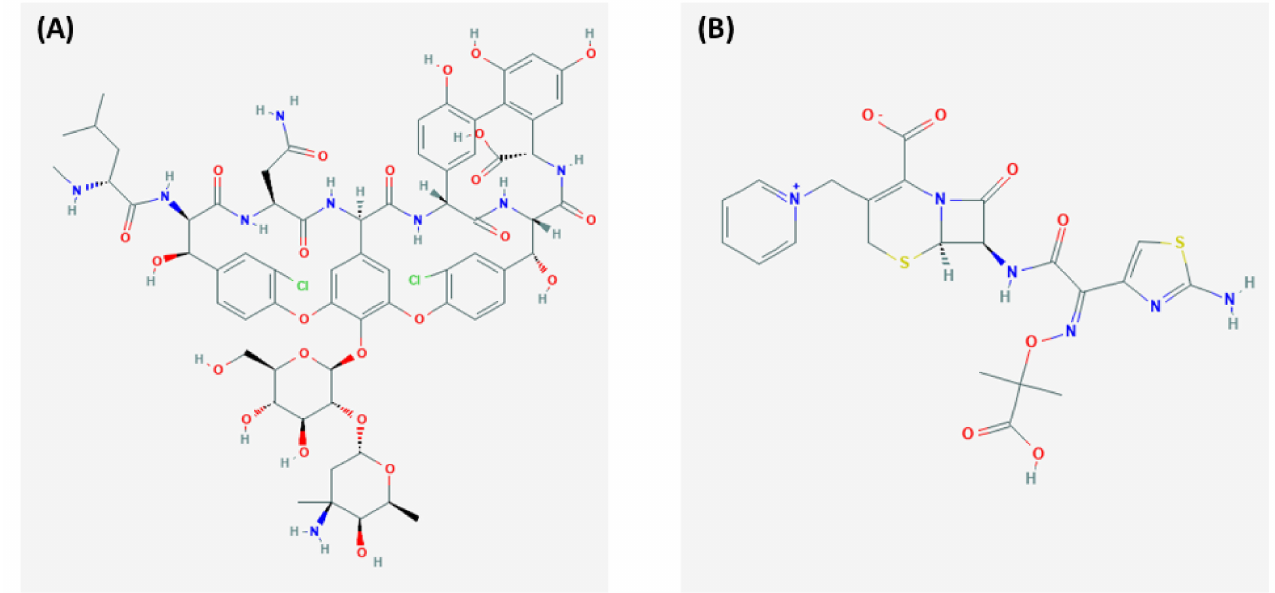
Figure 1. Chemical structure of vancomycin ( A ) and ceftazidime ( B ). Publicly available from [14]. Cyclodextrins (CDs) are cyclic natural oligosaccharides consisting of 6 ( α CD), 7 ( β CD) or 8 ( γ CD) glucose monomers linked via α -1,4-glycosidic bonds. The molecules are shaped similar to a doughnut with a hydrophilic outer surface and a somewhat lipophilic central cavity. The natural CDs and their complexes being rather poorly water-soluble,